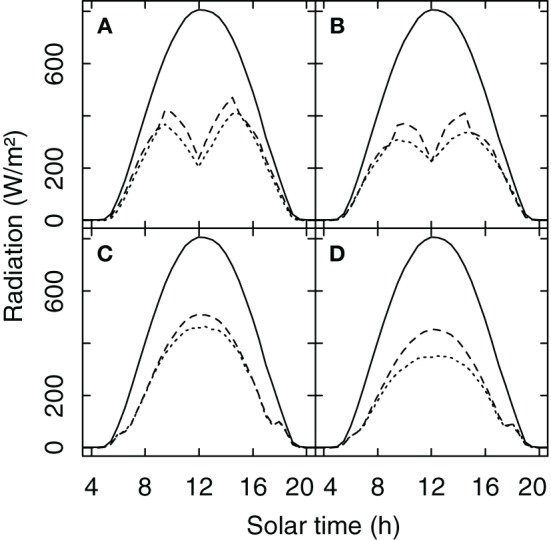
Global radiation and the simulated amount of radiation received by a row oriented grapevine canopy (Rv) (row distance 1.60 m, width = 0.40 m, height 1.10 m, 0.80 m above ground). For North-South (A,B) and for South-East (C,D) row orientation and for porosity levels of the foliage of 0.25 (A,C) and 0.5 (B,D). Solid lines show global radiation for a clear sky day in Geisenheim, Germany (20-Aug-2011), the dashed lines show Rv simulated with the model of Riou et al. (1989), and the dotted line Rv calculated with a Monte Carlo simulation.